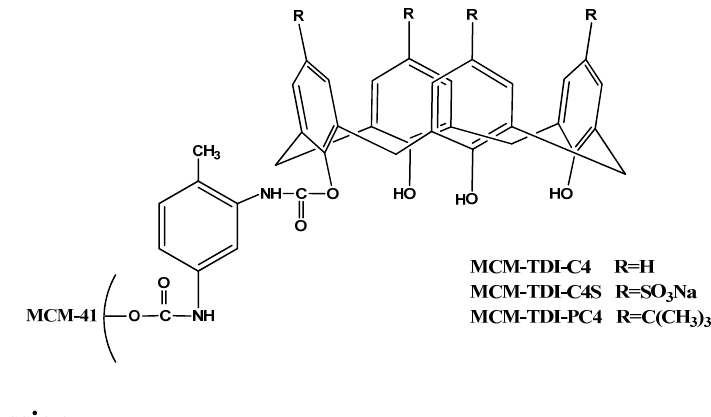
Figure 1. Chemical structures of the synthetic